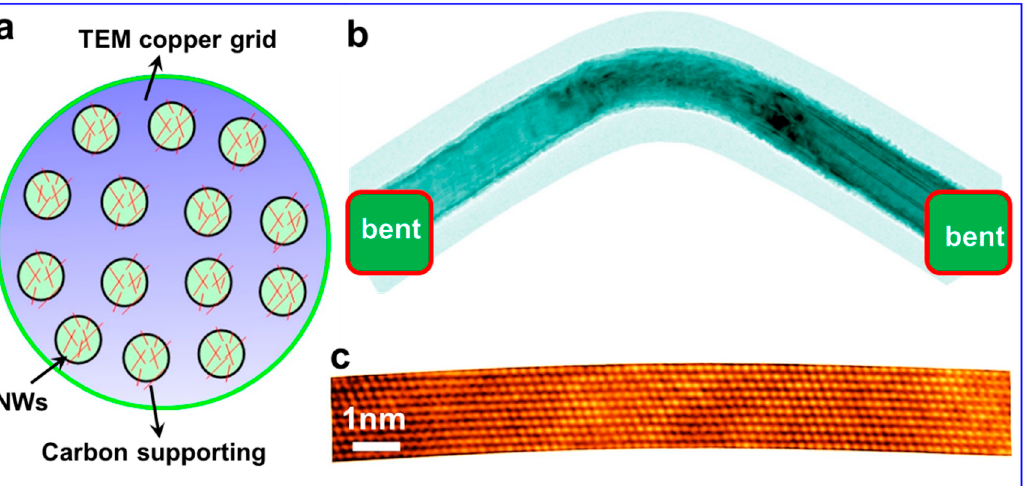
Figure 1. ( a ) Schematic showing the twin-structured Ni NWs scattered on the previously broken TEM grid, which was covered by colloidal thin films. ( b ) An example showing that a single NW could be bent using the colloidal thin films. ( c ) HTEM image showing the highly bent, arc-shaped {111} lattices.